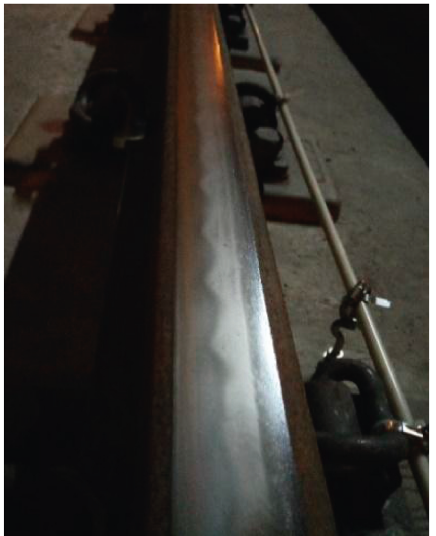
Figure 4: Rail with wave corrugation.